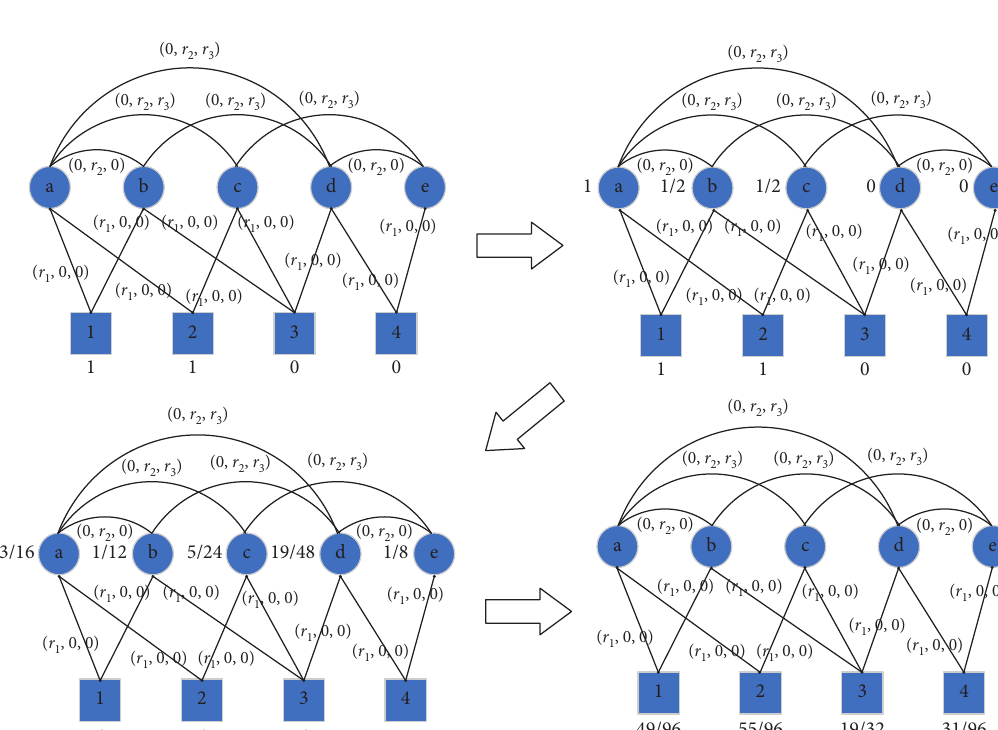
Figure 4: The diffusion process of SDM2